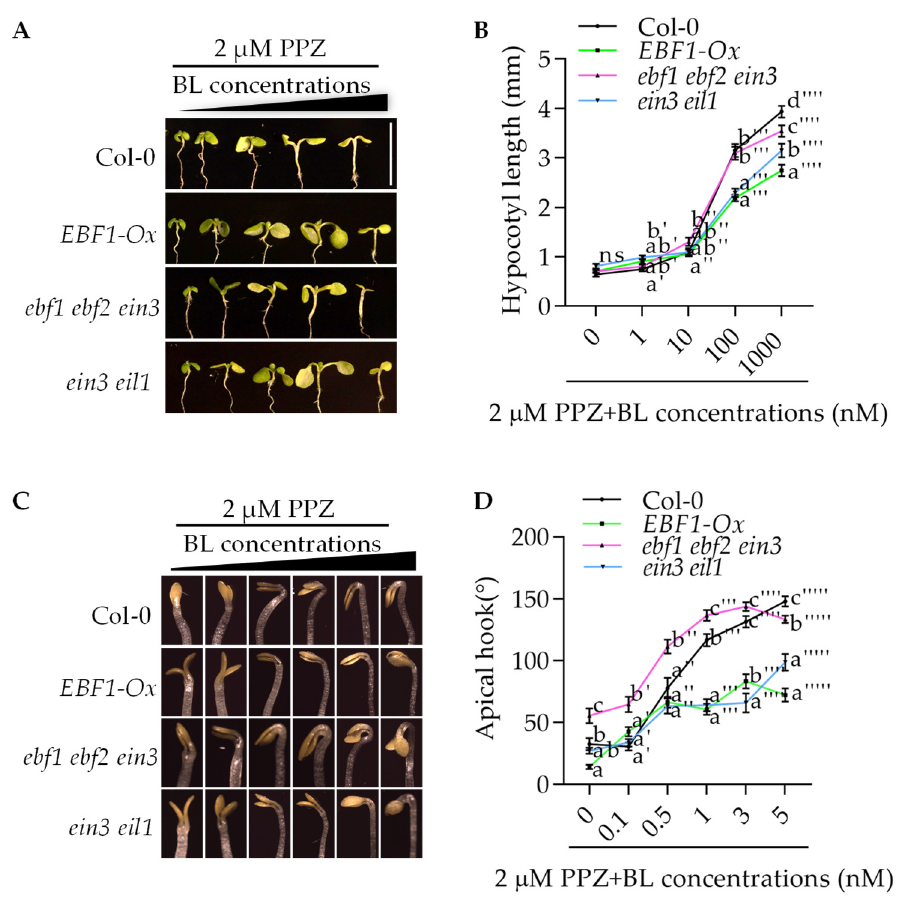
Figure 1. EBF1 inhibited BR-promoted cell elongation and apical hook formation. ( A , B ) The hypocotyl length of Col-0, EBF1-Ox , ebf1 ebf2 ein3 and ein3 eil1 seedlings that were grown on 1 / 2 MS medium supplied with 2 µ M PPZ plus different concentrations of BL in white light for 7 days. Data are shown as means ± se; n = 15. Scale bar = 1 cm. Different letters above bars indicate statistically significant differences between samples (two-way ANOVA followed by post hoc Tukey test, p < 0.05). ( C , D ) The apical hook curvature of Col-0, EBF1-Ox , ebf1 ebf2 ein3 and ein3 eil1 seedlings that were grown on 1 / 2 MS medium supplied with 2 µ M PPZ plus different concentrations of BL in darkness for 4 days. Data are shown as means ± se; n = 15. Scale bar = 1 cm. Different letters above bars indicate statistically significant differences between samples (Two-way ANOVA followed by post hoc Tukey test, p < 0.05).